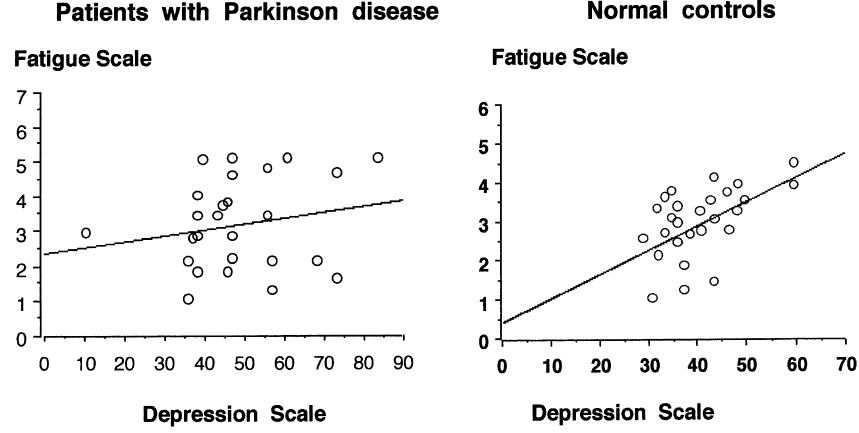
Fig. 2. Correlation between the fatigue Scale and the self assessed depression scale In patients with ParkinsonŠs disease, there was no significant correlation between the depression scale and the fatigue scale (left; r = 0 . 19 , p > 0 . 20 ). In controls, there was a significant correlation between the depression scale and the fatigue scale (right; r = 0 . 58 , p < 0 . 05